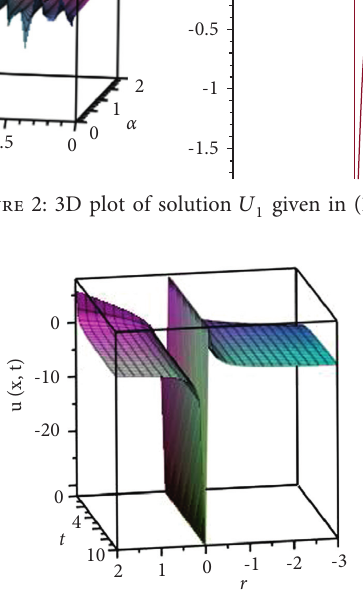
Figure 3: Graph of solution U